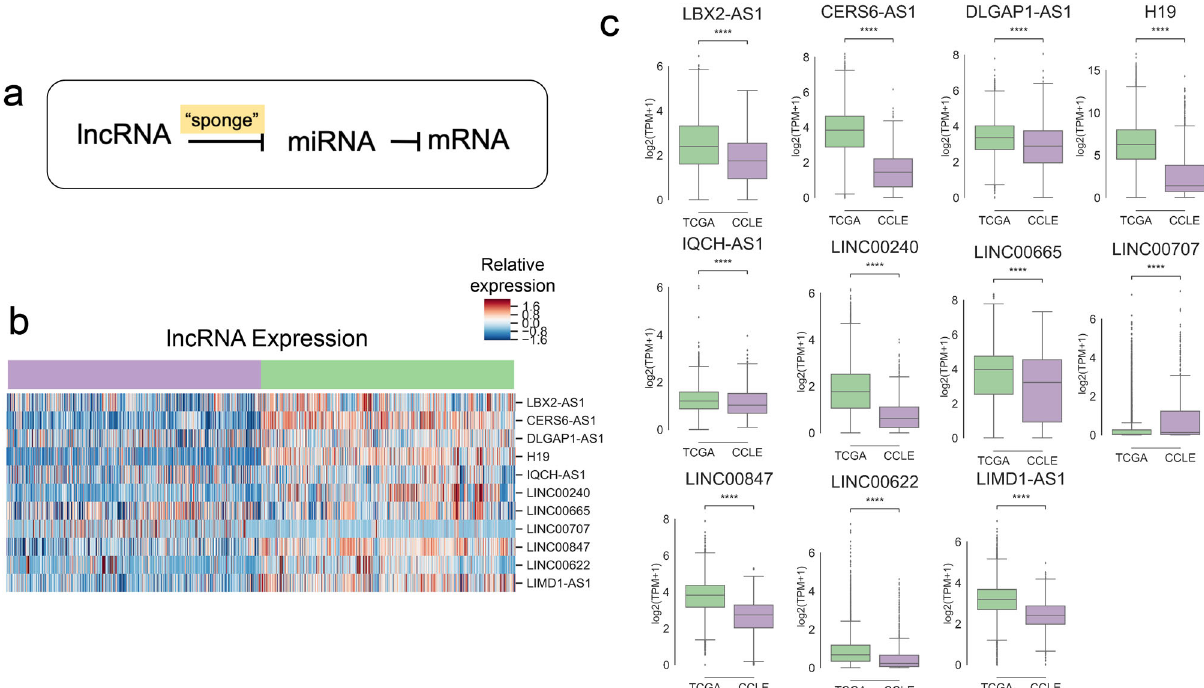
Fig. 3 Long non-coding RNA associated with four cancer driver pathways are signi fi cantly underexpressed in cancer cell lines. a In the “ sponge ” model of lncRNA gene expression regulation, lncRNA competitively inhibit miRNA which would otherwise be responsible for inhibiting mRNA. b Heatmap showing expression of 11 lncRNAs with miRNA-dependent associations to protein-coding genes in the four cancer driver pathways. The samples shown are a random subset with equal representation from each dataset in each disease. c Boxplots showing expression of the 11 lncRNA associated with four cancer driver pathways. All samples from both datasets are shown. (Two-sided Mann – Whitney signi fi cance test; * P value < 0.05, ** P value < 0.01, *** P value <